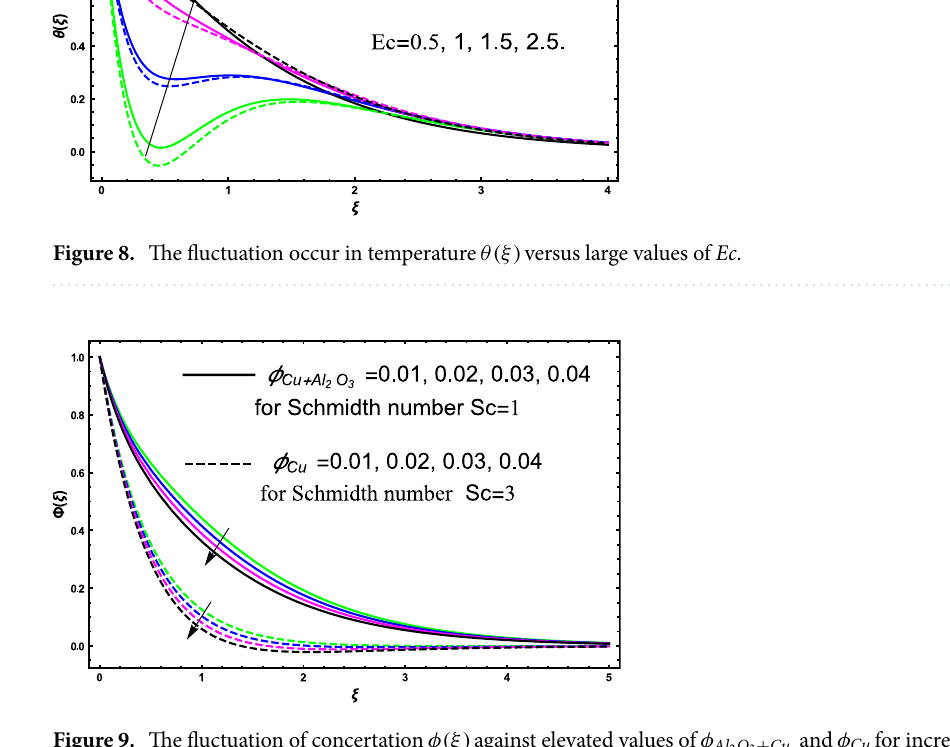
Figure 9. The fluctuation of concertation φ(ξ) against elevated values of φ Al 2 O 3 + Cu and φ Cu for increasing values of Sc